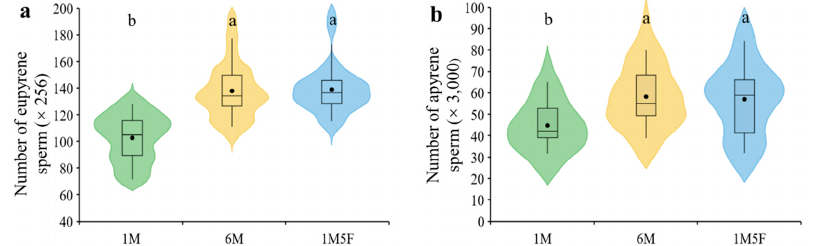
Figure 2. Effect of socio-sexual environment during the pupal stage on the number of eupyrene ( a ) and apyrene ( b ) sperm in testes of E. kuehniella . 1M, one male; 6M, six males together; 1M5F, one male and five females together. Each box plot shows the range between the first and third quartiles (black box), mean (black dot) and median scores (black lines); and ‘violin’ shapes show the shape of the distribution. Different letters on the top of the shapes denote significant differences between treatments ( p < 0.05).